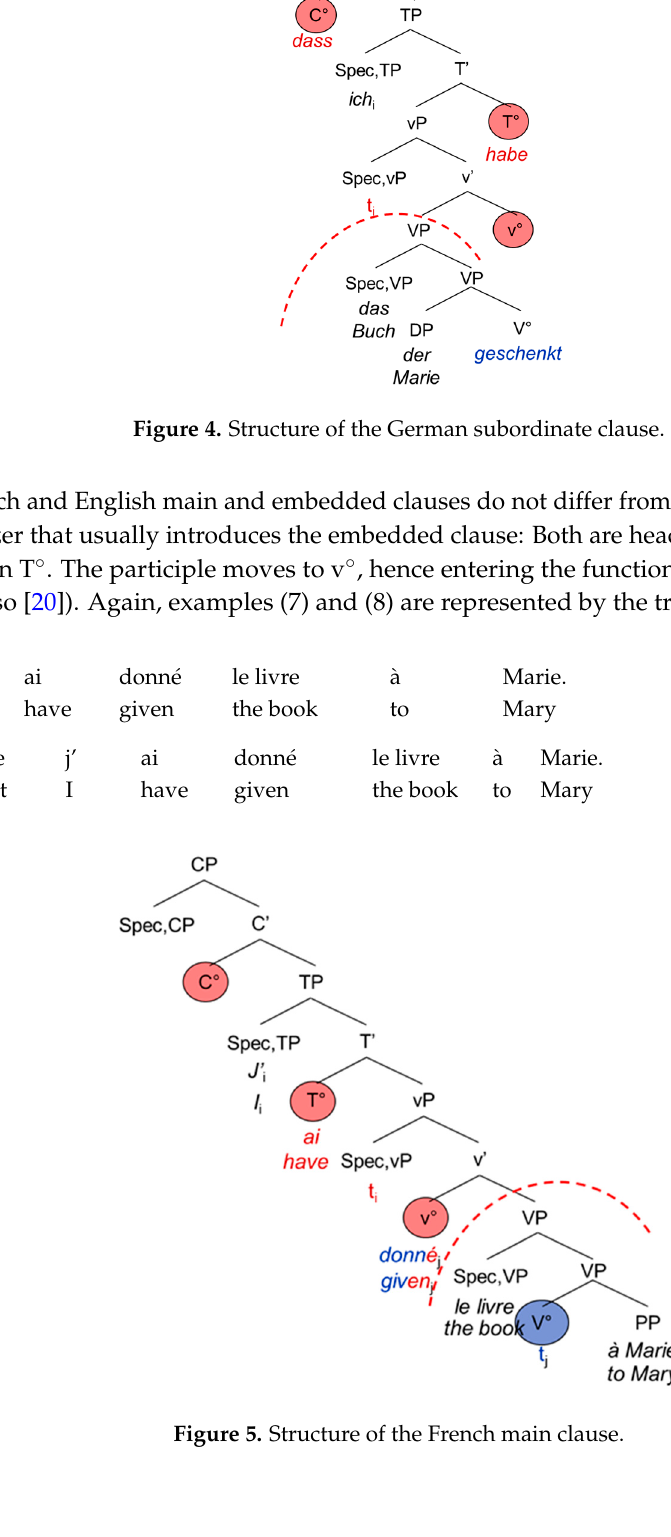
Figure 6. Structure of the French subordinate clause. According to the PA, the theta filter (thematic roles, cf. [21]) must be satisfied and there is agreement (person, number) inside the CP (e.g., between the subject and the verb). The PFR further states that there should not be any CS in the functional domain, namely between the morphological exponents of the complementizer (C°) and the verbal morphology (the exponents of T° and v°). The differences between the syntactic architecture of German and that of French and English lead to interesting asymmetries in the possibility for CS, as [1] has been observed for German ‐ Spanish bilinguals. Since the participle enters the functional domain in Spanish, but not in German, it is possible to switch the code for the German participle (9b), but not for the Spanish one (9a): 9.